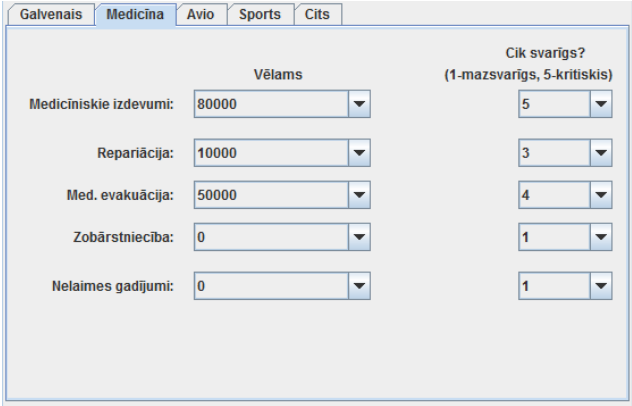
Fig. 7. Preference input of the category